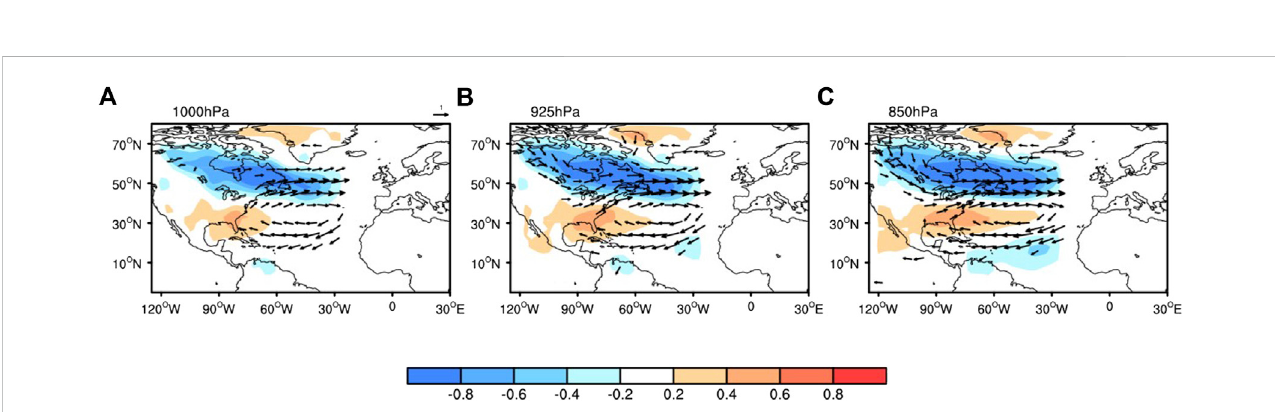
FIGURE 2 Correlation maps of the DJFM-averaged air temperature (shading, units: ° C) and wind (vectors, units: m\s) anomalies with the simultaneous NADI at (A) 1000 hPa, (B) 925 hPa and (C) 850 hPa. Positive (red) and negative (blue) air temperature anomalies with correlations signi fi cant at or above the 90% con fi dence level are shaded. Only wind vectors signi fi cant at the 90% con fi dence level are